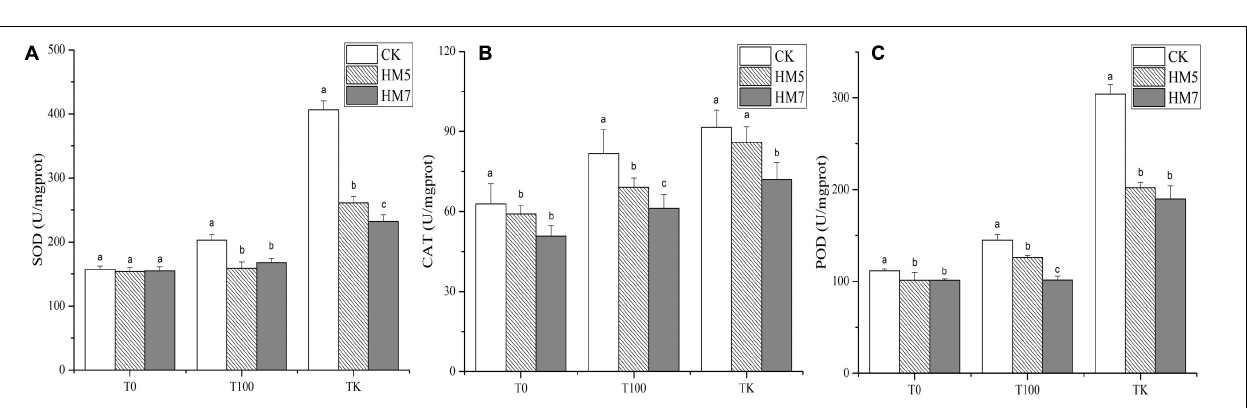
FIGURE 2 | The content of MDA, PRO, protein, and soluble sugar in B. papyrifera . (A) The content of MDA. (B) The content of PRO. (C) The content of protein. (D) The content of soluble sugar.